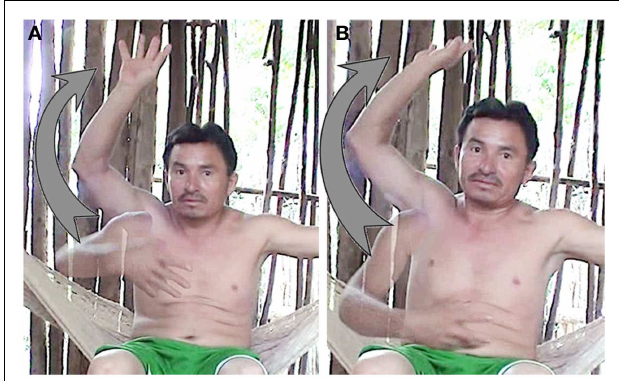
FIGURE 7 | Gestures for (A) ts’uyúuchtal “(it was) long ago” and (B) yan uyúuchtal “it will be in a long time” (IPM).